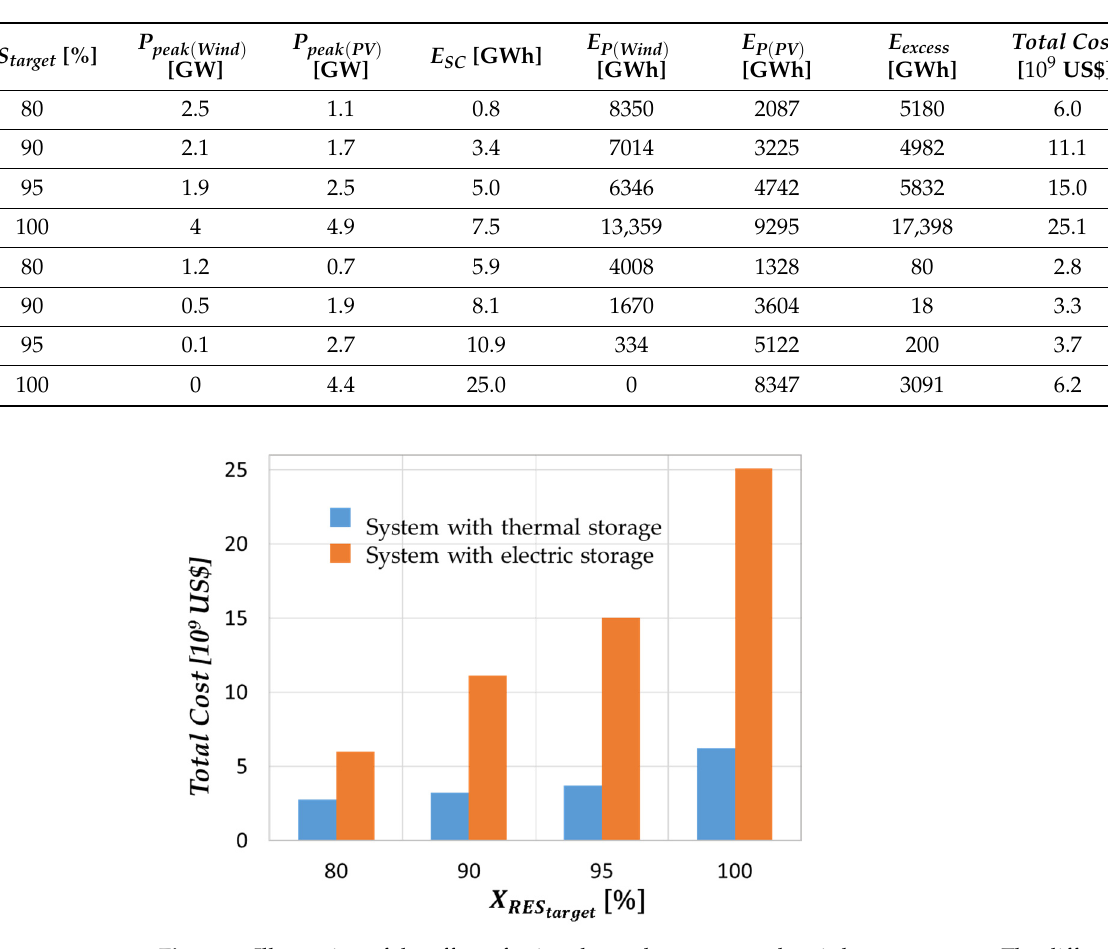
Table 7. Summary of the configurations that have the lowest capital initial cost for each RES target from 80% to 100%.